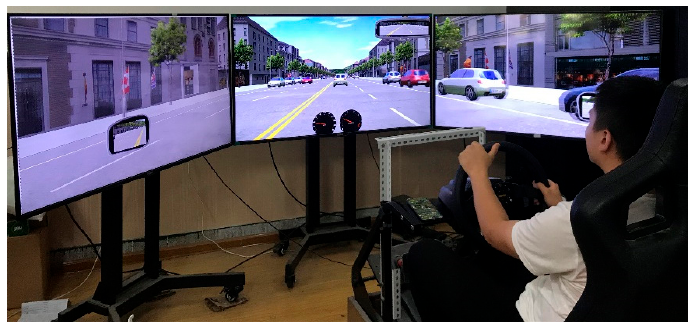
Figure 1. The driving simulator. Table 1. Statistical description of the participants obtained from the questionnaire.